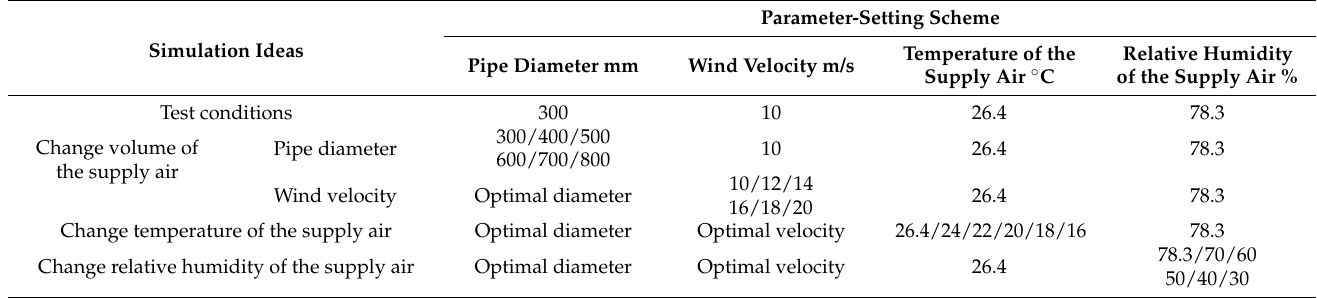
Table 5. The Parameter-Setting Scheme of Mobile Refrigeration Equipment.